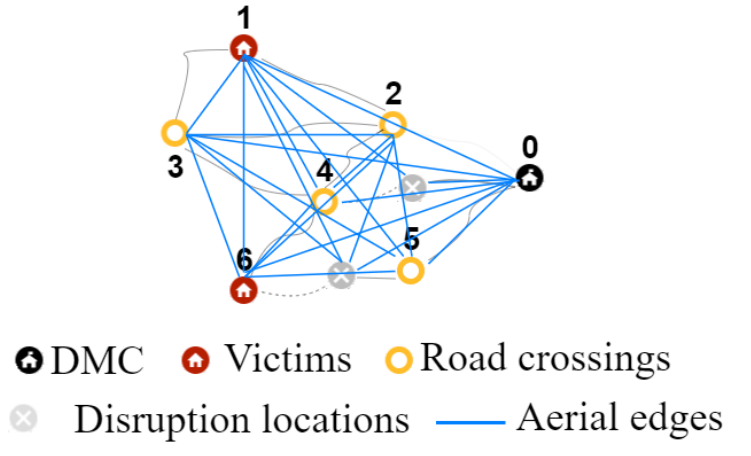
Figure 3. Aerial